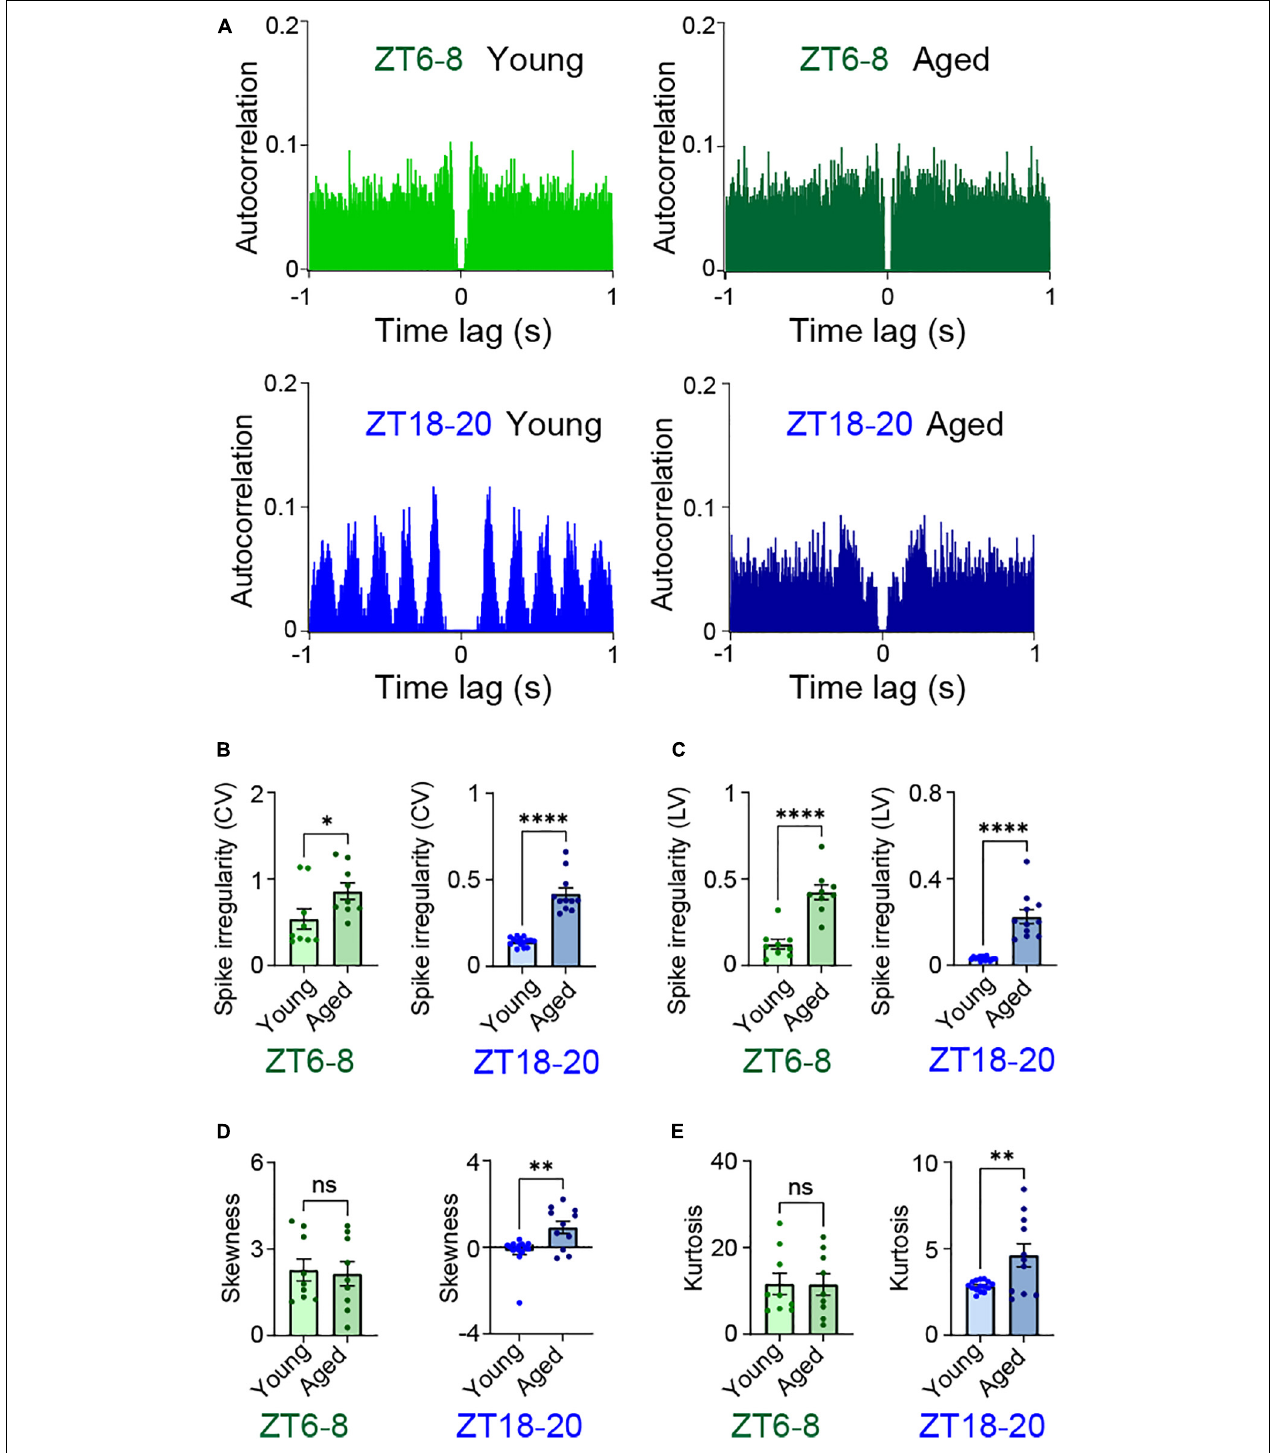
FIGURE 2 | Aging altered spike patterns during spontaneous activity. (A) Autocorrelation functions of spontaneous firing in young and aged DN1p neurons at ZT6–8 and ZT18–20. (B–E) Statistical parameters related to temporal structural regularity of spike trains in young and aged DN1p neurons at ZT6–8 and ZT18–20 (ZT6–8, young: n = 9, aged: n = 9; ZT18–20, young: n = 15, aged: n = 11; same data used in Figure 1 ). Spike irregularity shown as the ratio of standard deviation to the mean of ISIs (coefficient of variation, CV) (B) , spike irregularity shown as the dispersion of two adjacent ISIs (local variation, LV) (C) , degree of asymmetry of the probability distribution of ISIs (skewness) (D) , and measure of the sharpness of the probability distribution of ISIs (kurtosis) (E) . ∗ p < 0.05, ∗∗ p < 0.01, and ∗∗∗∗ p < 0.0001 based on t -tests.